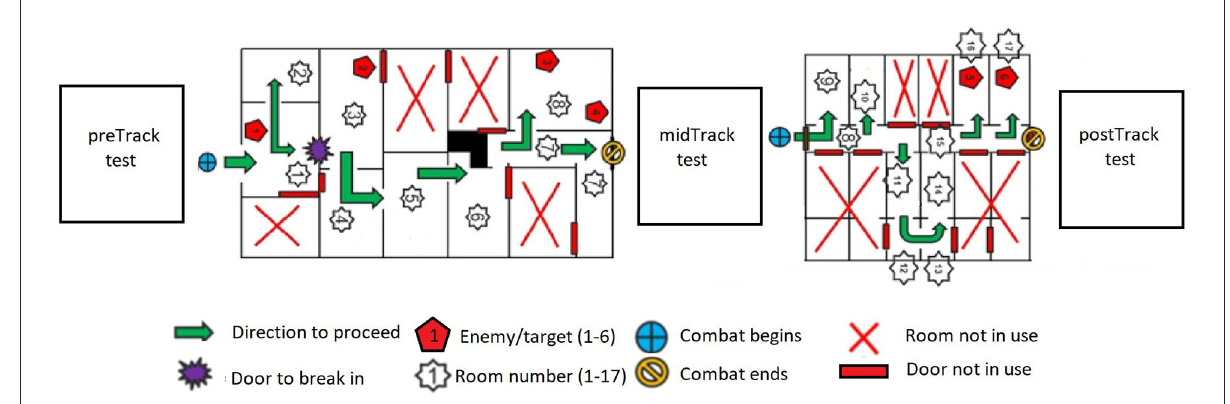
FIGURE2 Overview of the main activities and the urban buildings included in the